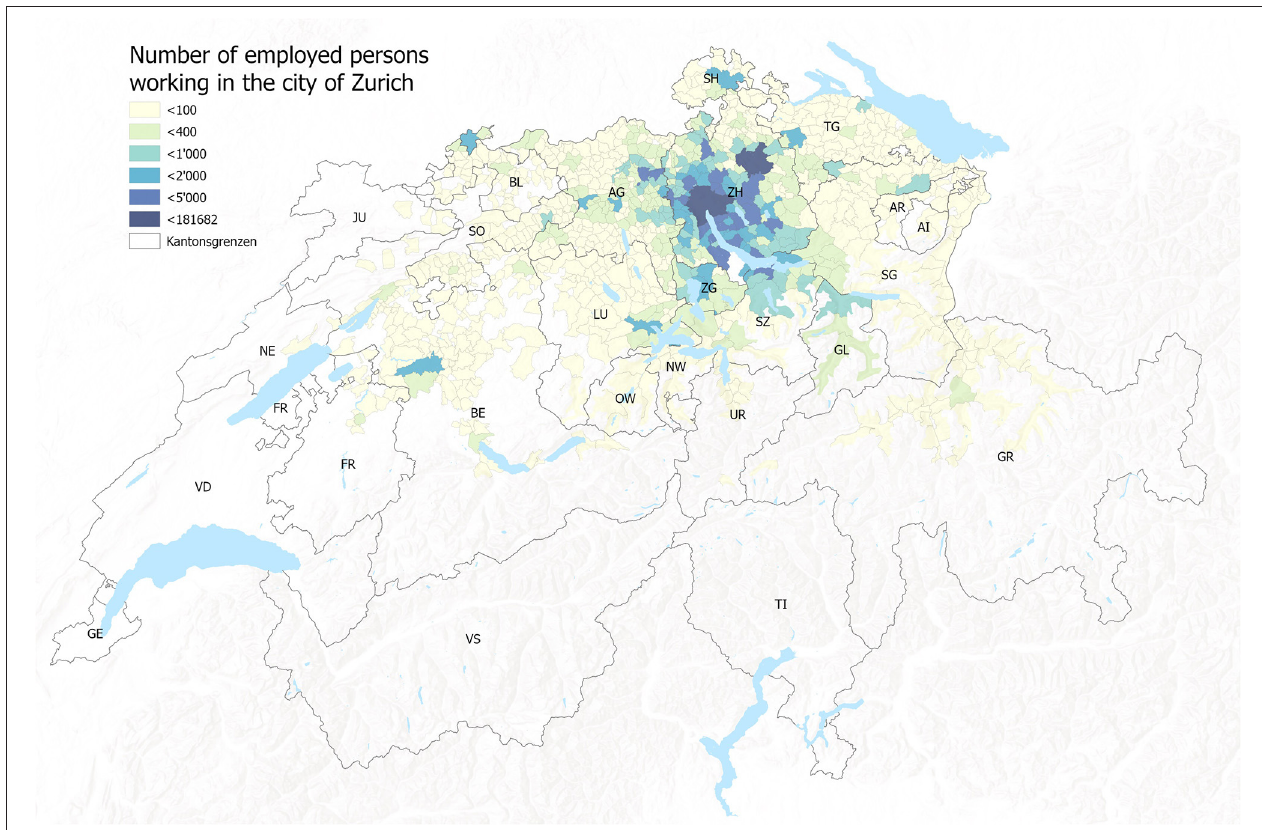
FIGURE 5 | Commuter catchment area for the city of Zurich, illustrating the fact that commuters regularly come and go from more than 11 different cantons. Source: ( 37).